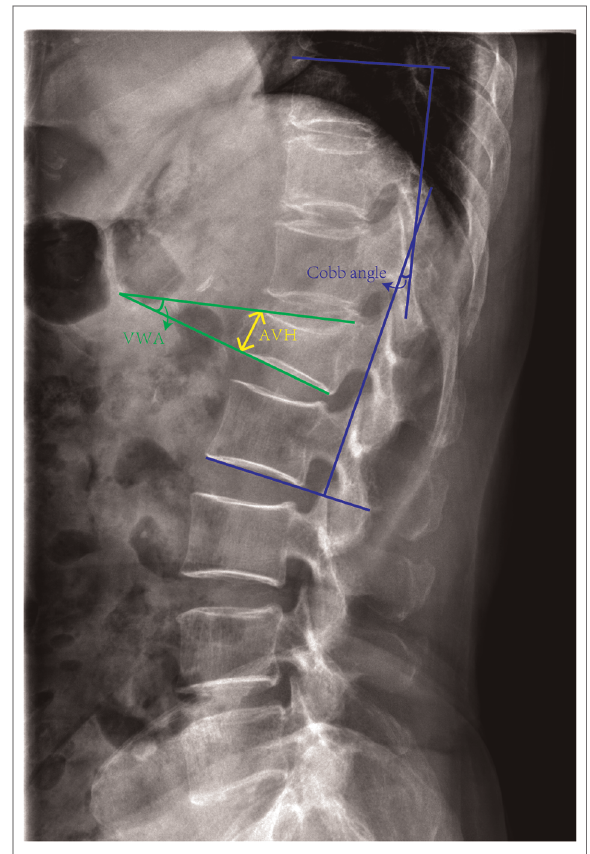
FIGURE 4 The de fi nition of AVH, VWA and Cobb angle. The AVH refers to the height of the anterior vertebra. The VWA was de fi ned as the angle between superior and inferior endplates of the fractured vertebra. The Cobb angle was considered as the angle between the upper endplate of T10 and the lower endplate of L2.